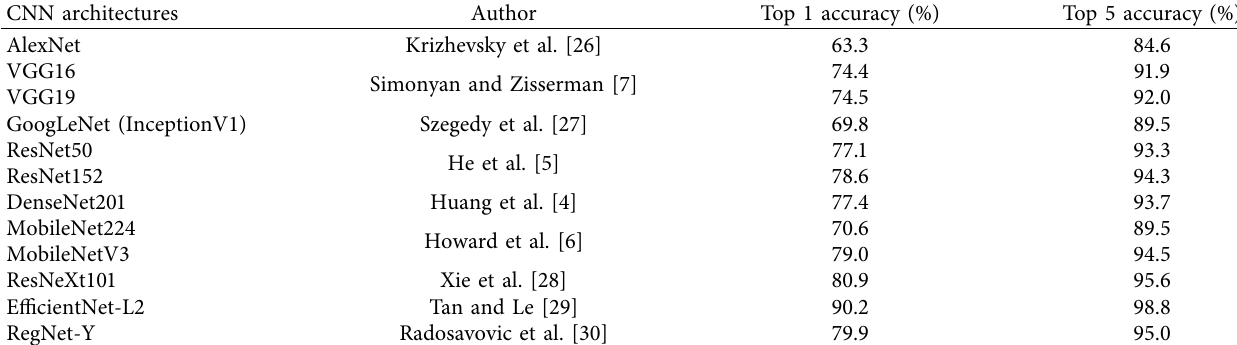
Table 2: Some CNN architectures and ImageNet benchmark (image classification).